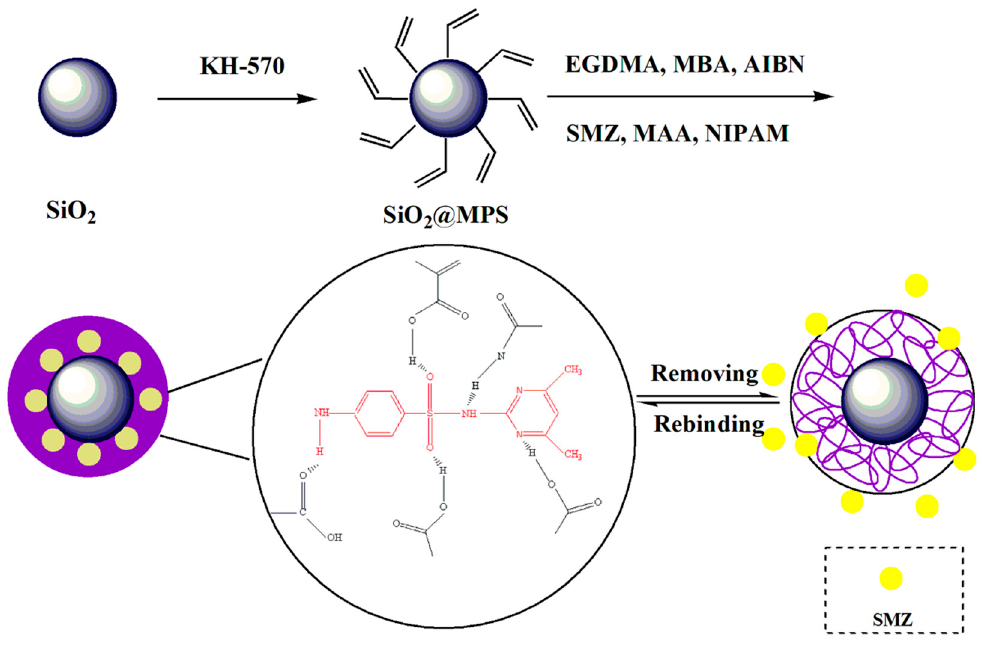
Figure 1. Schematic diagram of thermosensitive molecularly-imprinted polymers (MIPs) based on the surface of silica.